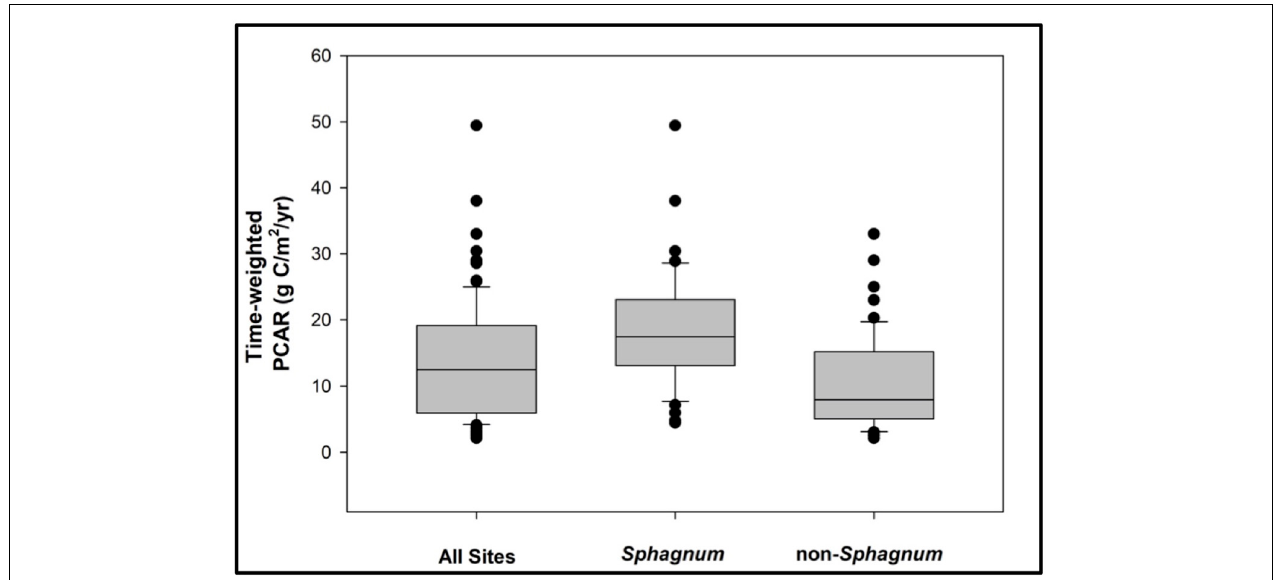
FIGURE 7 | A comparative analysis of time-weighted peat-carbon accumulation rates (PCAR) for Sphagnum vs. non- Sphagnum peat types. The Sphagnum sites have been characterized by an overall greater C-sink capacity than the non- Sphagnum sites (Tukey’s HSD: p <